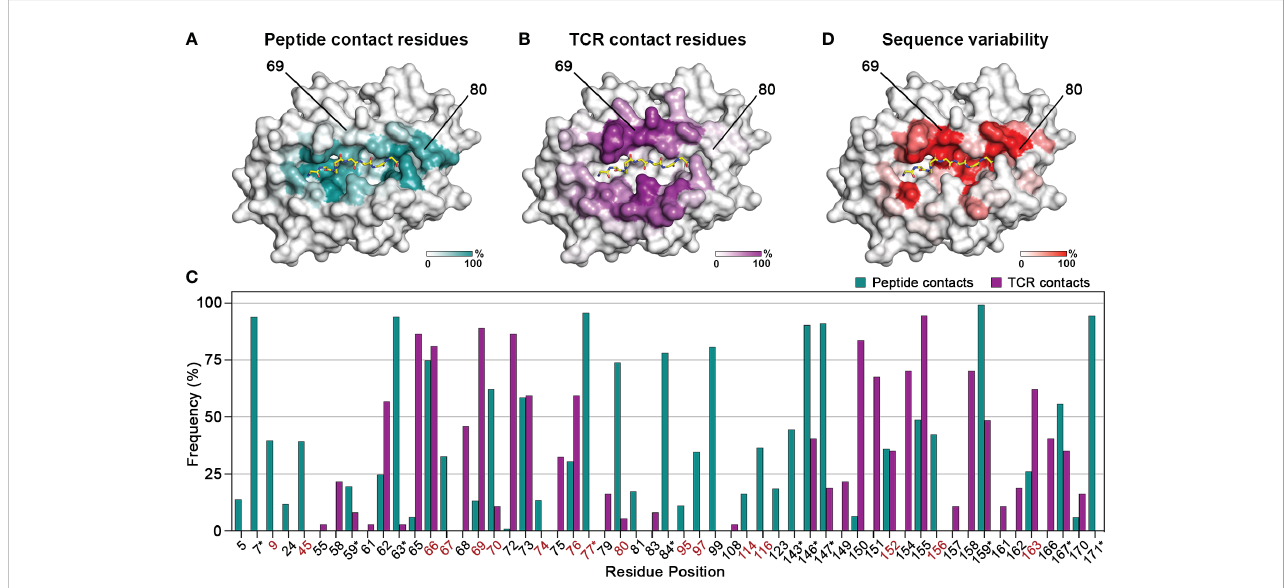
FIGURE 1 Contiguous molecular surfaces de fi ned by polymorphic HLA residues mediate interactions with peptides, and TCRs. The calculated (A) peptide-contact, and (B) TCR-contact frequencies of the fi rst 180 amino acids are highlighted in a white (low) and teal or purple (high) gradient, respectively. The structure of HLA A*02:01 (PDB ID: 1S9W) was used as template. (C) Bar graph of the peptide- and TCR-contact frequencies for positions with at least one value higher than 2%. Polymorphic positions with a consensus score below 60% are highlighted in red, while residues that form conserved hydrogen bond networks with the peptide main chain are marked with an asterisk (*) (52). (D) Sequence variability for each position P plotted as (100 - Consensus score) on the HLA-A*02:01 structure, from a white (low) to red (high)